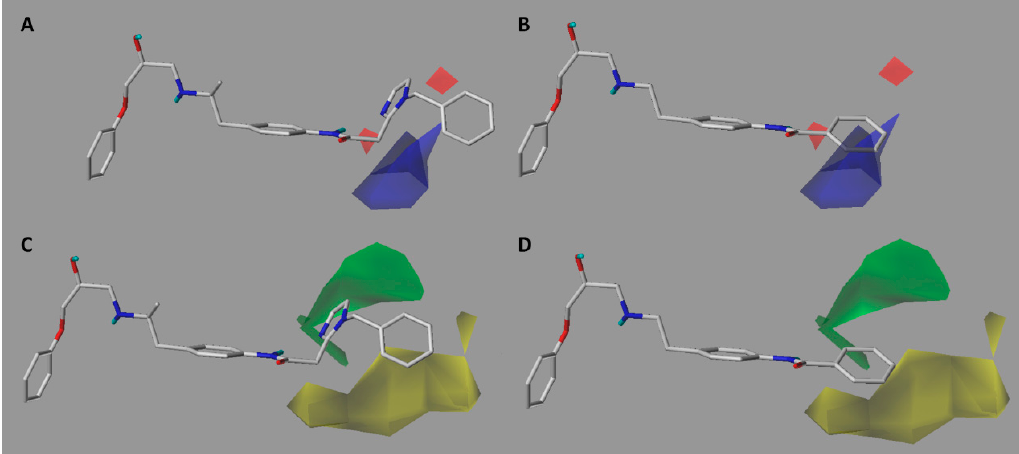
Figure 3. CoMFA electrostatic ( A , B ) and steric ( C , D ) contour maps around compounds 16 ( left ) and 21 ( right ), the most active and less active of the series respectively. Electropositive favored (blue) and electronegative favored (red). Sterically favored (green) and disfavored (yellow).